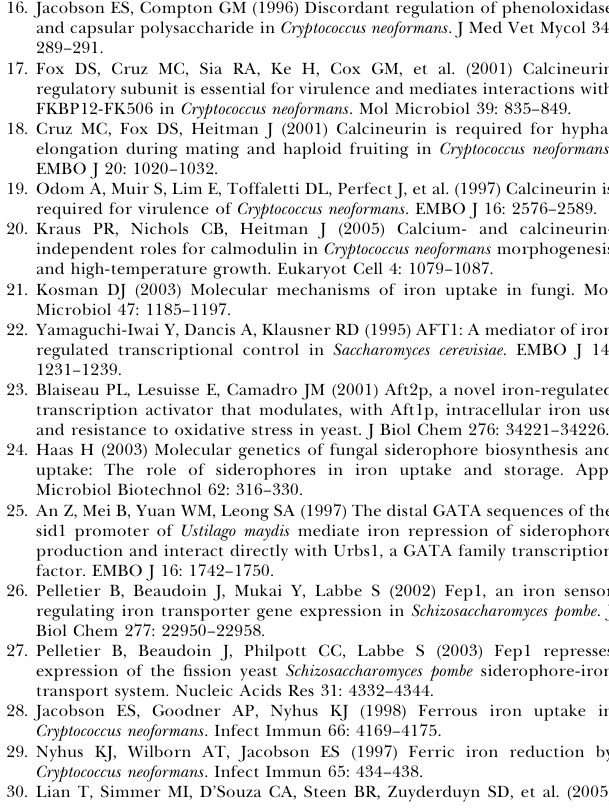
Table S1. Strains and Primers Used in This Study Table S2. Primers Used for RNA Blot